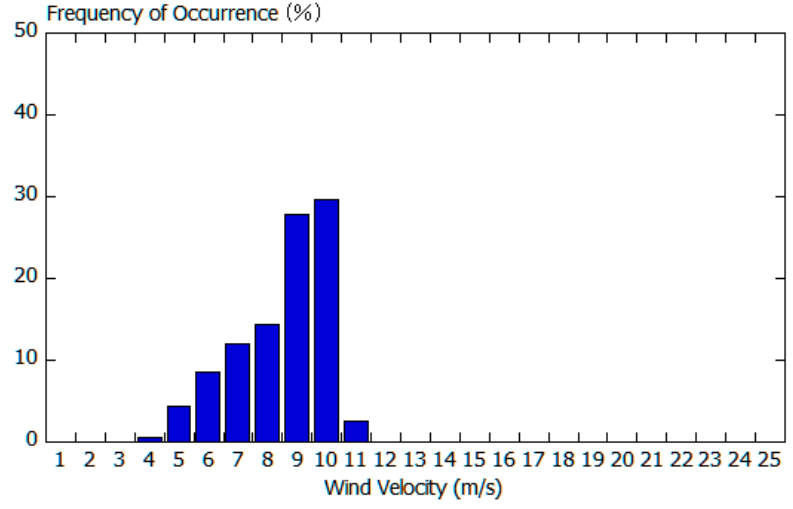
Figure 16. Frequency distribution of the streamwise (x) wind velocity that has been rescaled to full scale (m/s) for the time period shown in Figure 15.